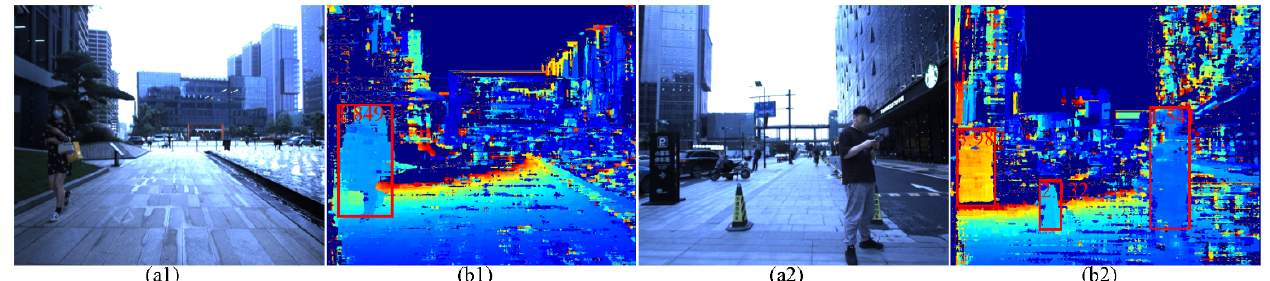
Figure 5. The object detection based on the depth images: ( a1 , a2 ) the color images with zero-degree polarization; ( b1 , b2 ) the depth images and the detection results. The detection results are labelled using the red bounding box.